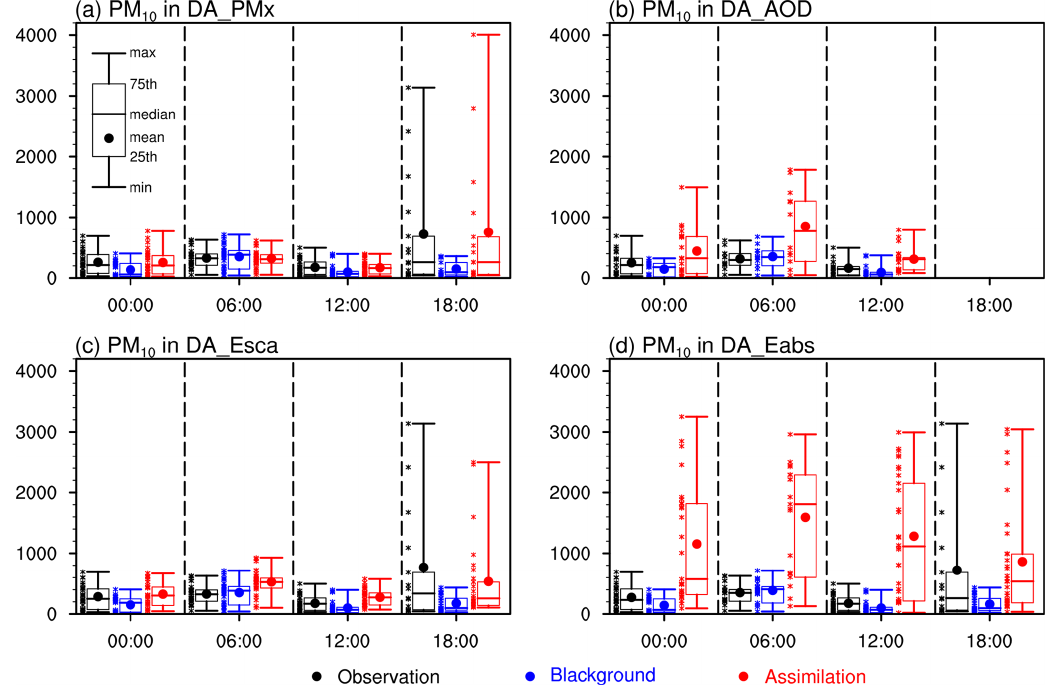
Figure 9. Surface PM 10 concentrations (µgm − 3 ) in the observation (black), background simulation (blue), and the DA analyses (red) at 00:00, 06:00, 12:00, and 18:00UTC in April 2019 when assimilating the observations of (a) PM x , (b) AOD, (c) aerosol scattering coefficients (Esca), and (d) aerosol absorption coefficient (Eabs), respectively. The DA_AOD had no analysis at 18:00UTC that was local midnight. Kashi is 6h ahead of UTC (UTC +